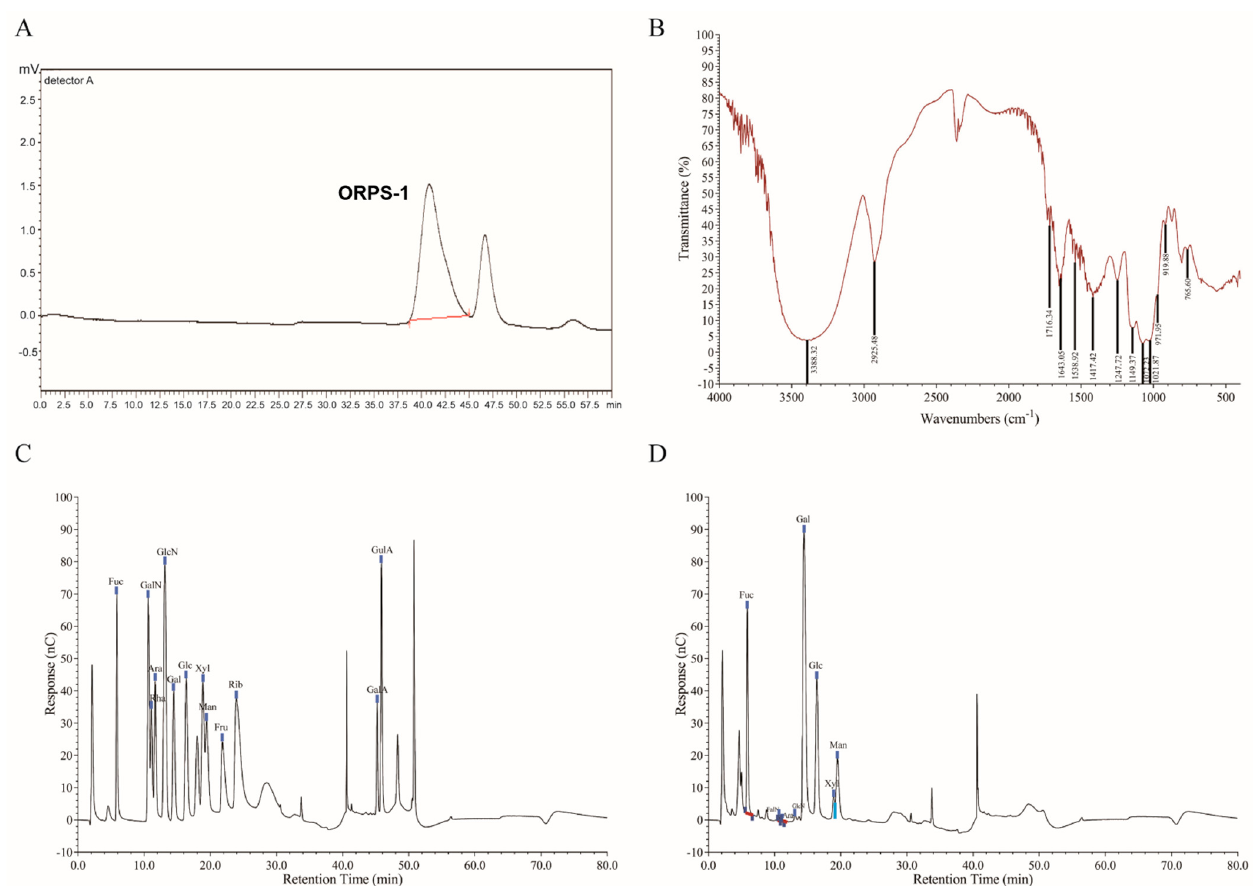
Figure 1. Primary structure analysis of ORPS − 1(ORPS, Oudemansiella raphanipies polysaccharide). ( A ) HPGPC chromatogram of relative molecular weight of ORPS − 1; ( B ) infrared spectroscopy analy- sis of ORPS − 1; ( C ) Ion chromatography of standard monosaccharides and ( D ) Ion chromatography of ORPS − 1. HPGPC, high-performance gel permeation chromatography; Ara, arabinose; GalA, galacturonic acid; GalN, galactosamine hydrochloride; GlcA, glucuronic acid; GulA, guluronic acid; Fuc, fucose; Fru, fructose; Rha, rhamnose; Gal, galactose; GlcN, glucosamine hydrochloride; Glc, glucose; GlcNAc, N − acetyl − D − glucosamine; Man, mannose; ManA, mannuronic acid; Rib, ribose; Xyl, xylose.